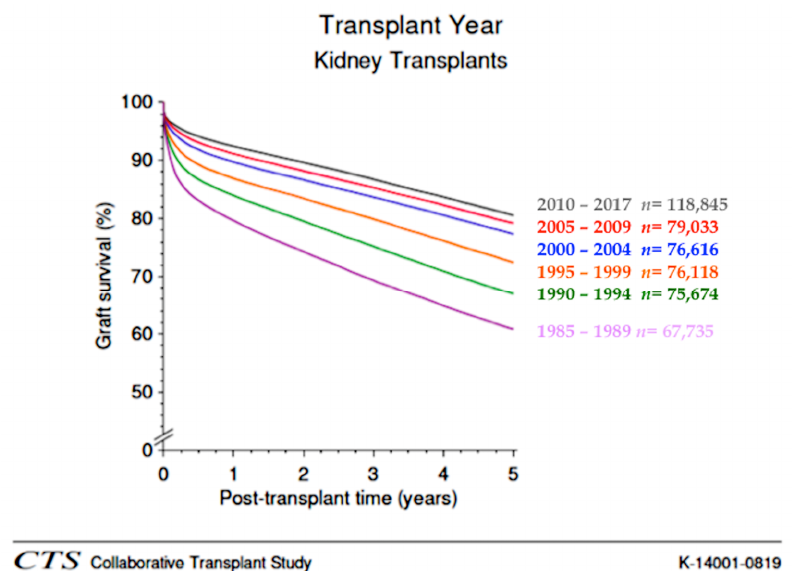
Figure 1. Graft survival of kidney transplantation according to decade of transplant. A significant improvement of short-term (<1 year) graft survival was observed through all decades as a likely consequence of reduction of acute rejection episodes. In contrast, while a significant improvement in long-term (>2 years) results was achieved between 1990 and 2000, a similar improvement has been not observed in recent decades (2000–2017) (obtained from CTS, K-14001-0819, accessed January 2020, www.ctstransplant.org).